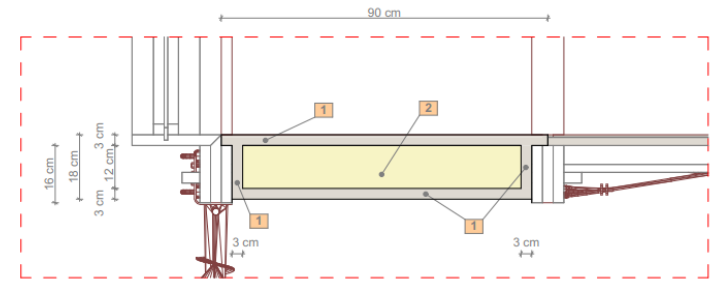
Figure 4. Floor stratigraphy in the basic THU configuration (1: OSB; 2: cork). Table 3. Thermo-physical and optical properties of the materials used for assembling the floor.